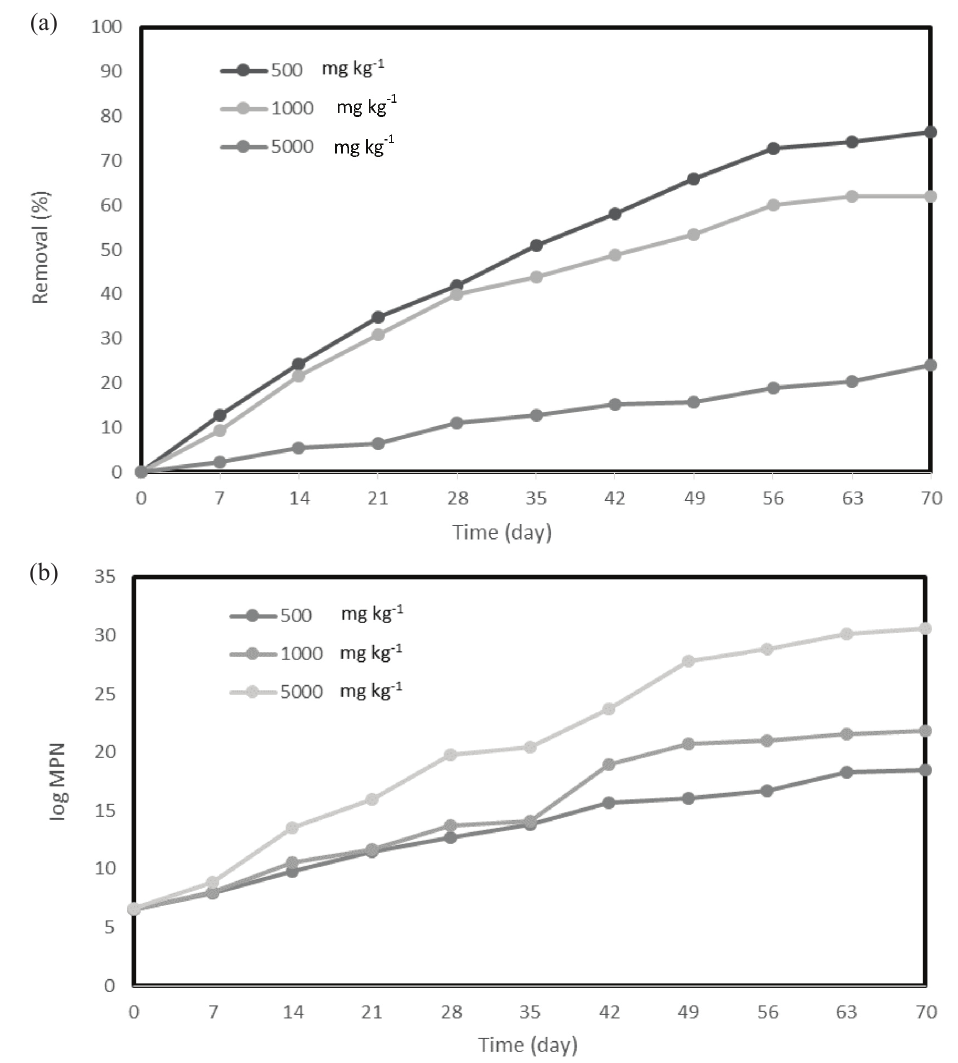
Table 2 – Removal efficiency of different HCs in unwashed soil through bioremediation using Paenibacillus glucanolyticus sp. strain T7-AHV with external addition of rhamnolipid in slurry phase